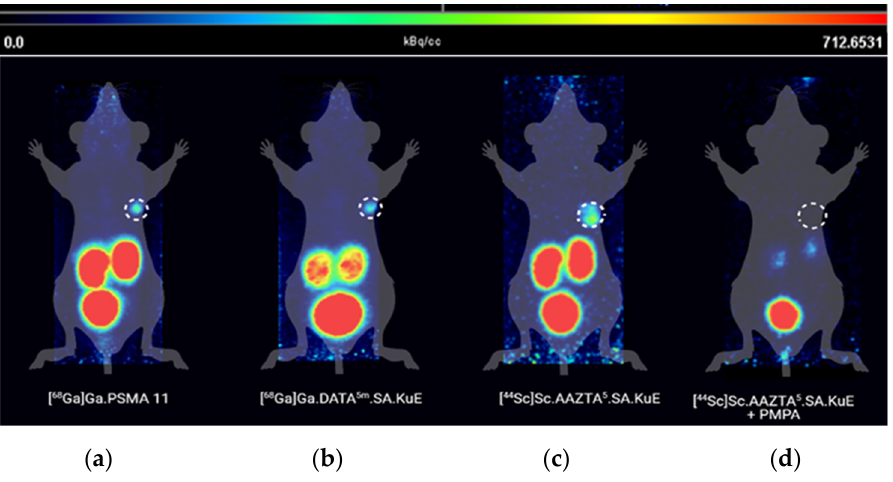
Figure 10. Ex vivo biodistribution of [ 68 Ga]Ga-DATA 5m .SA.KuE compared to organ accumulation after co-injection with an access PMPA.